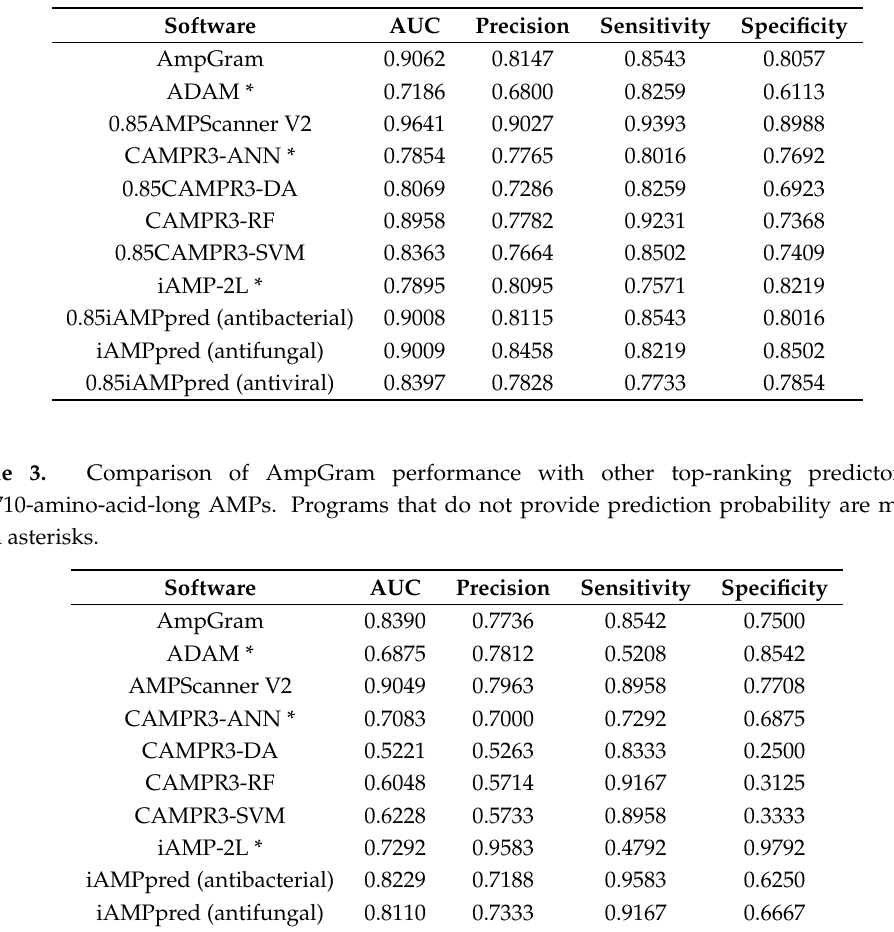
Figure 1. Comparison of AmpGram performance with other top-ranking predictors. Table 2. Comparison of AmpGram performance with other top-ranking predictors. Programs that do not provide prediction probability are marked with asterisks.